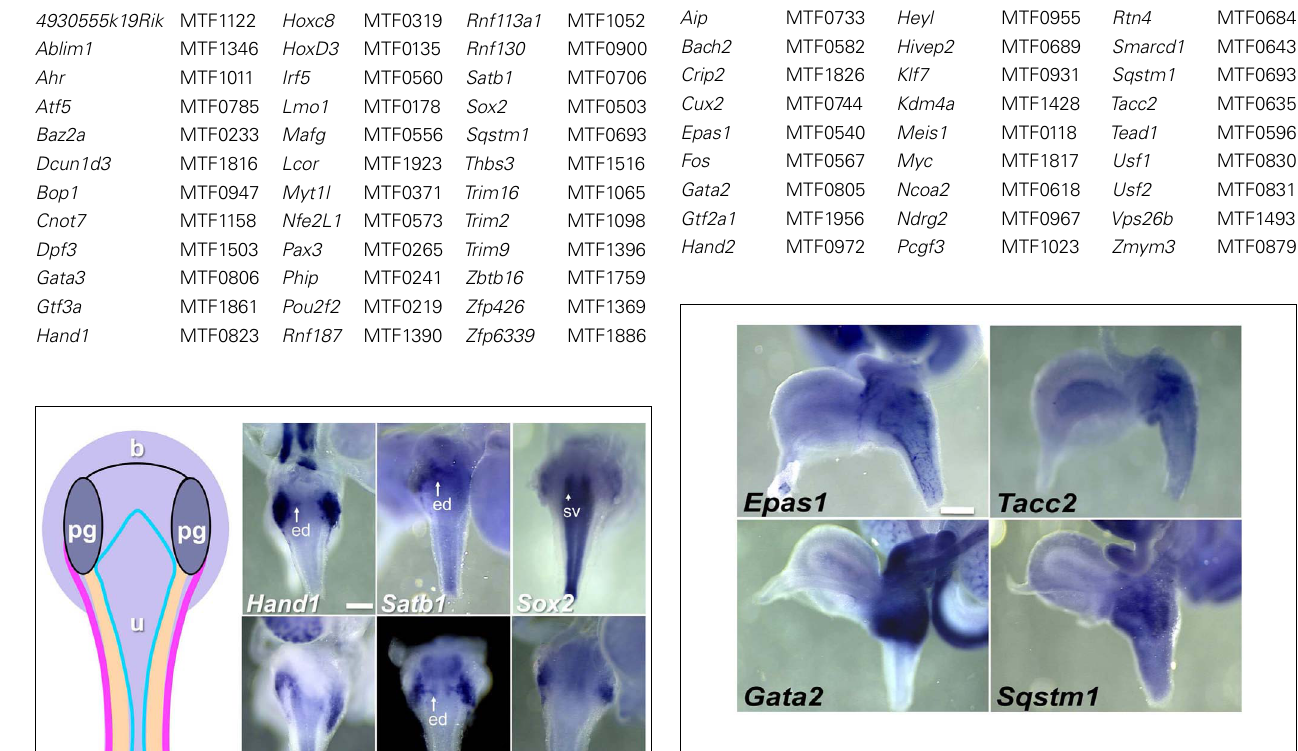
FIGURE 5 | Pelvic ganglia and urethral mesenchyme expression of genes in the fetal LUT identified byWISH. Lateral views of gene expression patterns detected for a subset of genes expressed in both pelvic ganglia and urethral mesenchyme. All images are 50 × magnification with a 300 µ m scale bar. Gene abbreviation/MGI gene ID/gender of sample: Epas1 /109169/female; Tacc2 /1928899/male; Gata2 /95662/female; Sqstm1